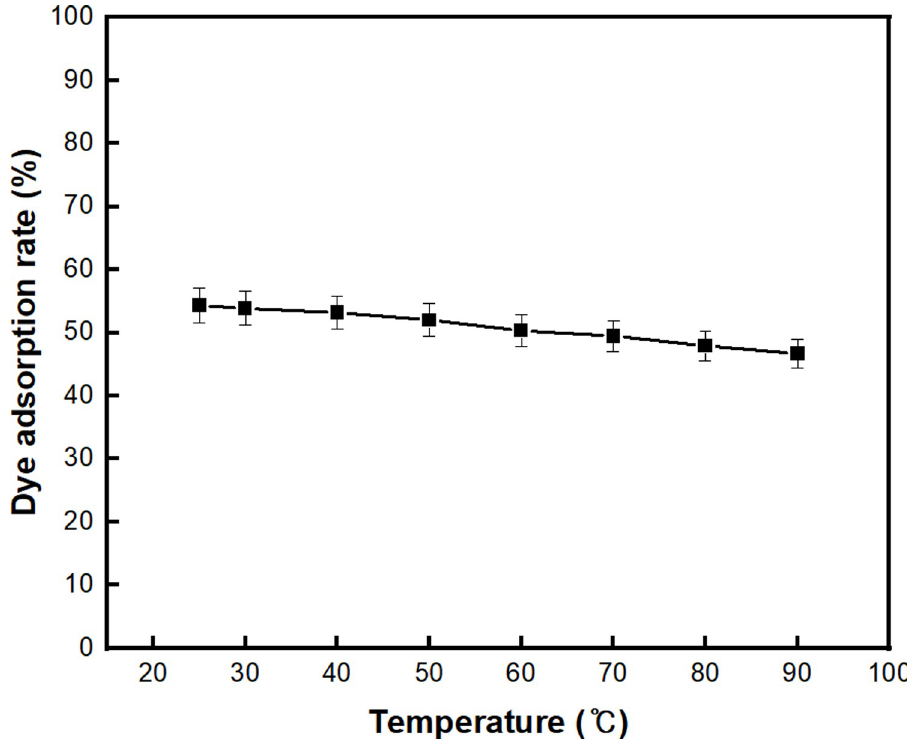
Fig 9. Dye adsorption rate (%) of BC-COF bio-leather with varied adsorption temperature (Extraction conditions: Liquor ratio of 1:10 (w/v), coffee at an amount of 200 wt% BC, 90˚C, 1 h; dyeing conditions: Fabric-to-liquor ratio of 1:10 (w/v), 70˚C, 30 min, meta-mordanting with 1% of FeSO 4 ; dye adsorption conditions: 50 mg/L of methylene blue solution with a fabric-to-liquor ratio of 1:200 (w/v), 30 min).